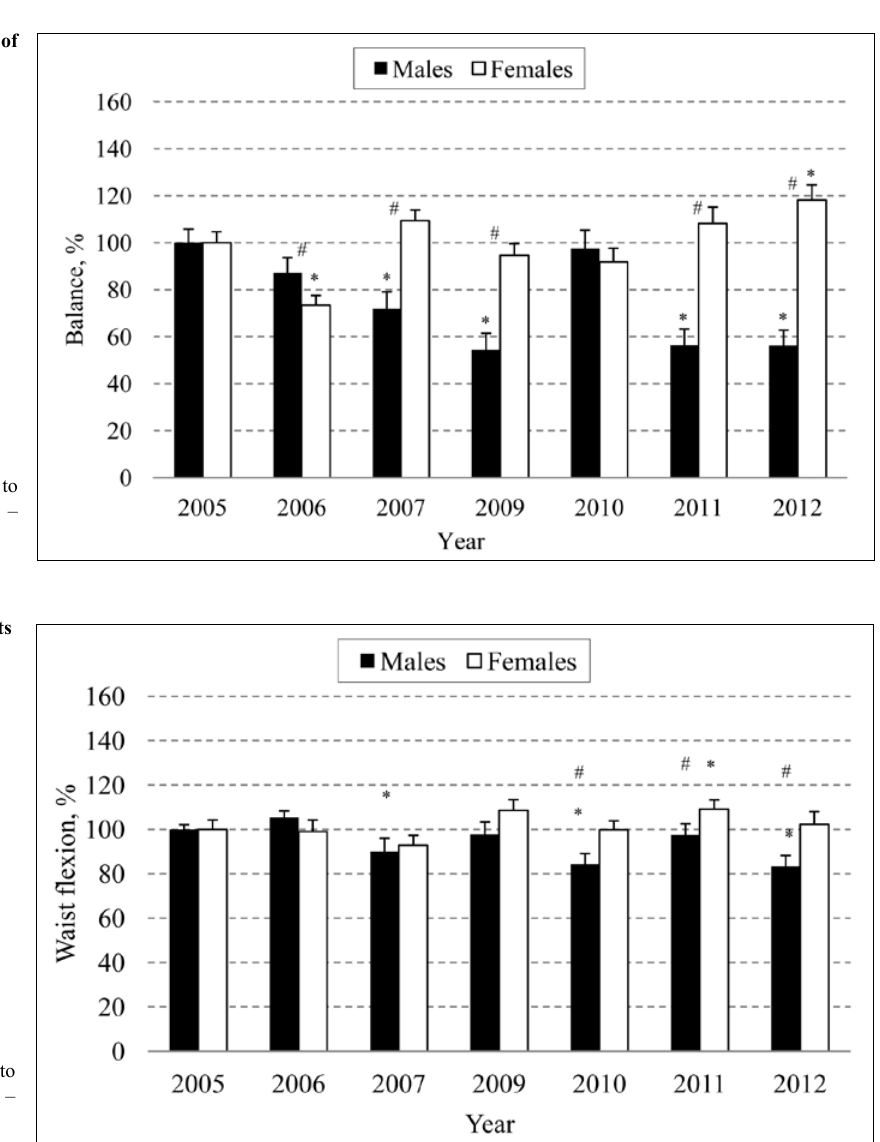
Figure 2. Balance test results of males and females